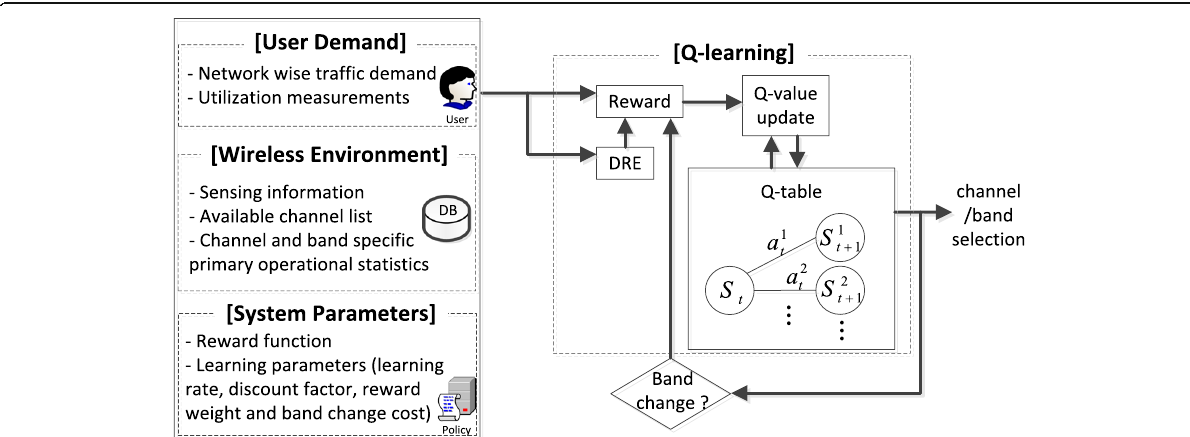
Fig. 3 Proposed system architecture. Proposed Q-learning is used to dynamically select the optimal band group and channel. As the reward function, the system considers the user demand, wireless environment and system parameters. The user demand module determines the desired data rate (DDR) of the CR ad-hoc network and measures the average utilization of the channel currently used. The wireless environment module stores the spectrum sensing results. The system parameters module is used to establish the reward function and Q-learning parameters. If the band of newly selected channel is different with the old one, the overhead for band group change is adopted to the reward function